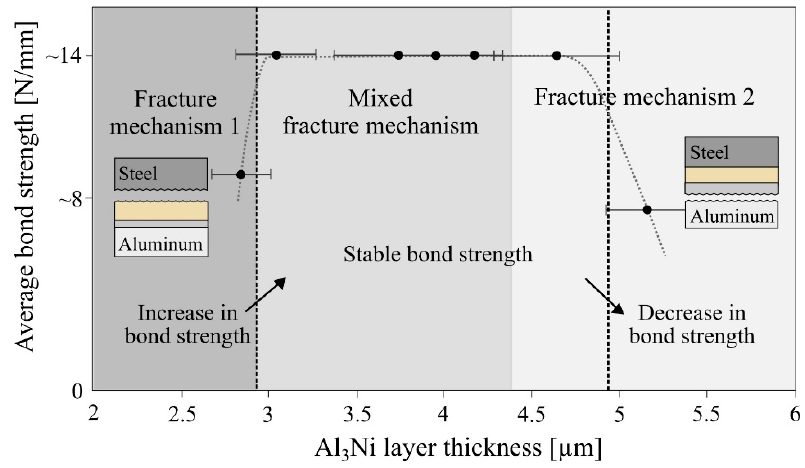
Figure 14. Graphical illustration showing the average bond strength as a function of Al 3 Ni phase layer thickness, based on the measurements obtained in the composites heat treated for one and two hours at 450 °C. The three different grey-colored areas indicate the different fracture mechanisms that were observed for the different Al 3 Ni layer thicknesses. Fracture mechanism 1; the fracture occurred along the steel-nickel interface and fracture mechanism 2; the fracture occurred along the Al 3 Ni-aluminum interface, as shown with the two small illustrations.